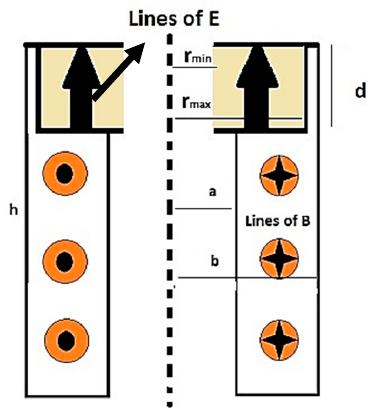
Figure 2. Inspired by Feynman as LC resonator. Lines of E and B are focused separately in the capacitive and inductive zones.